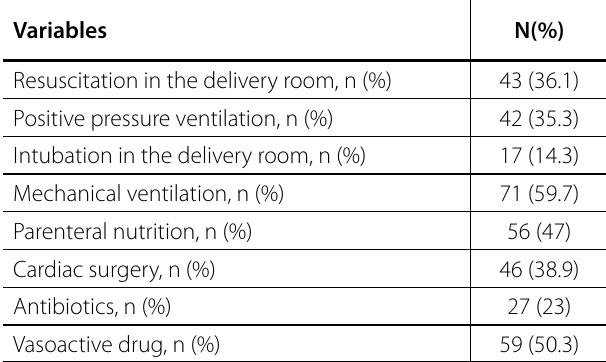
Table 3 . Interventions performed in the study population (n=119).